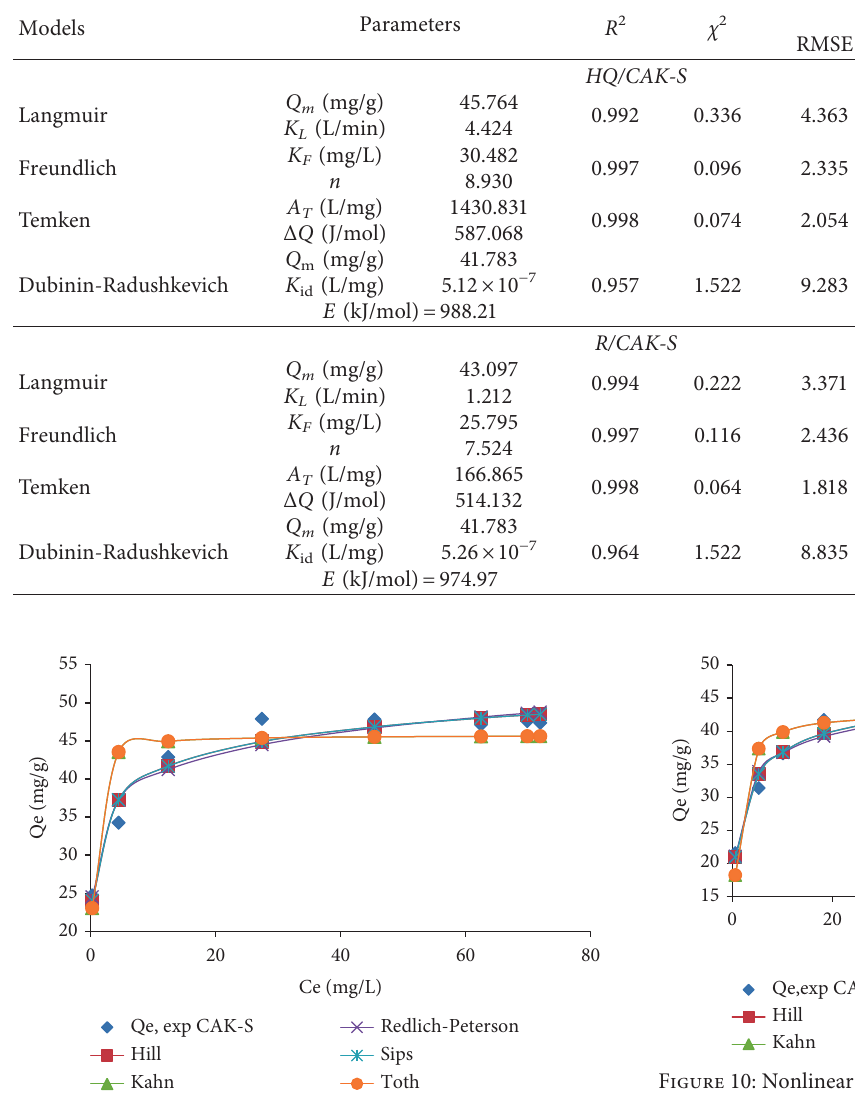
Figure 9: Nonlinear plot of three-parameter adsorption isotherm models of HQ by CAK-S.